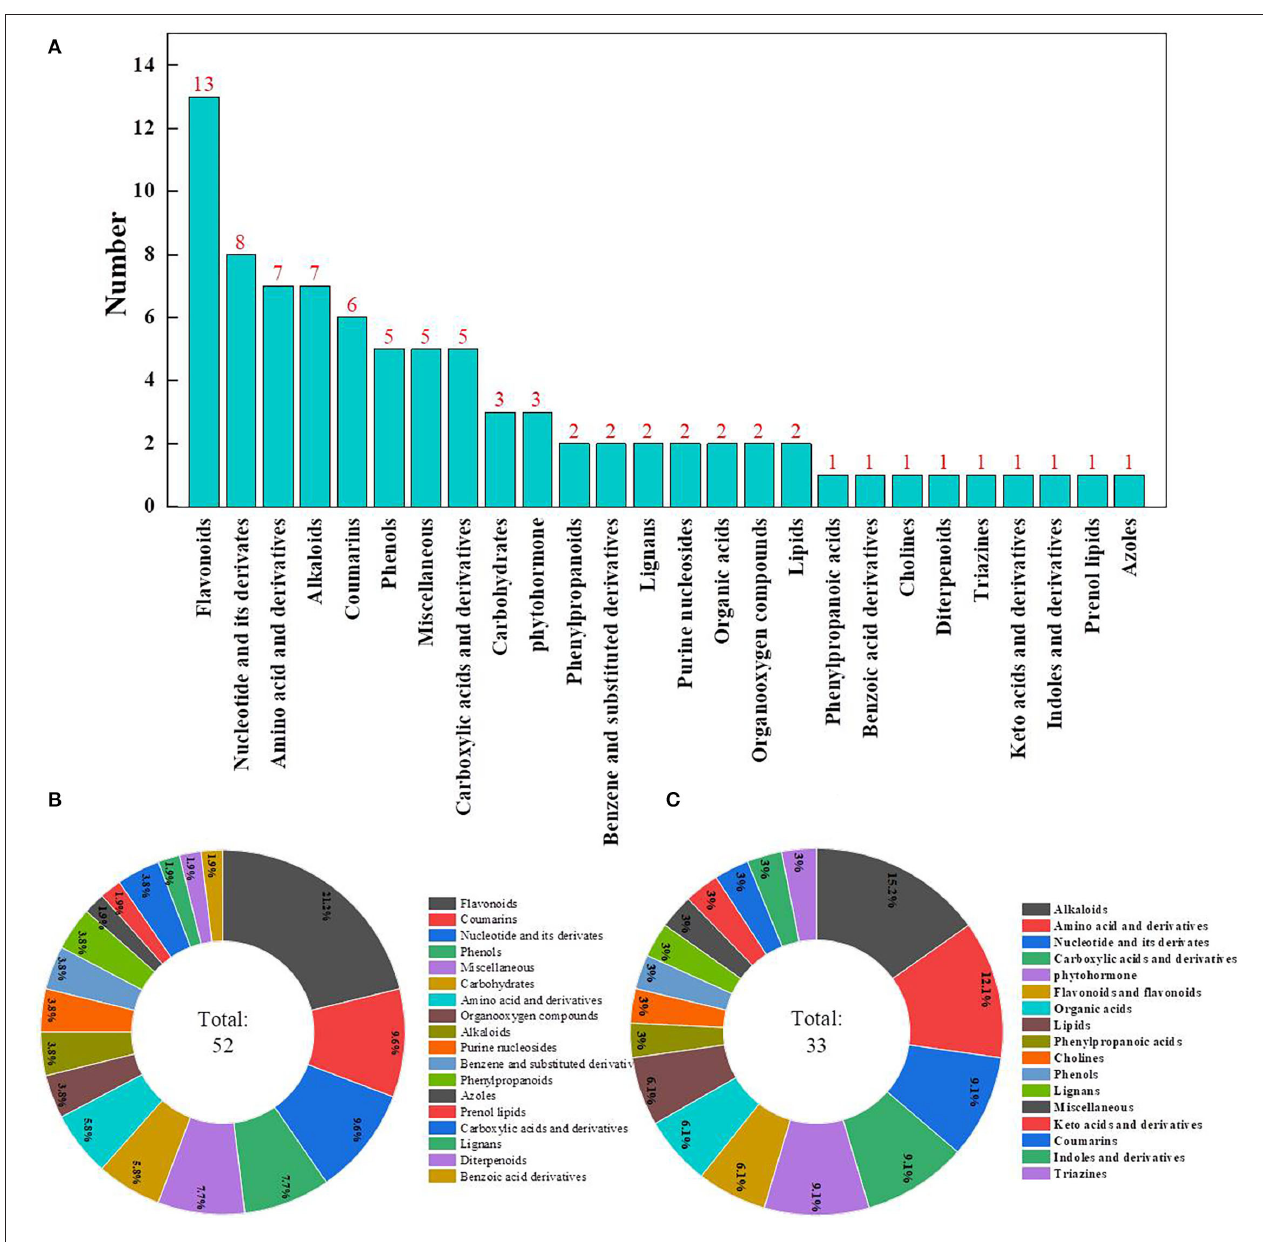
FIGURE 6 | Differential metabolite (A) , upregulated (B) , and downregulated category (C) .